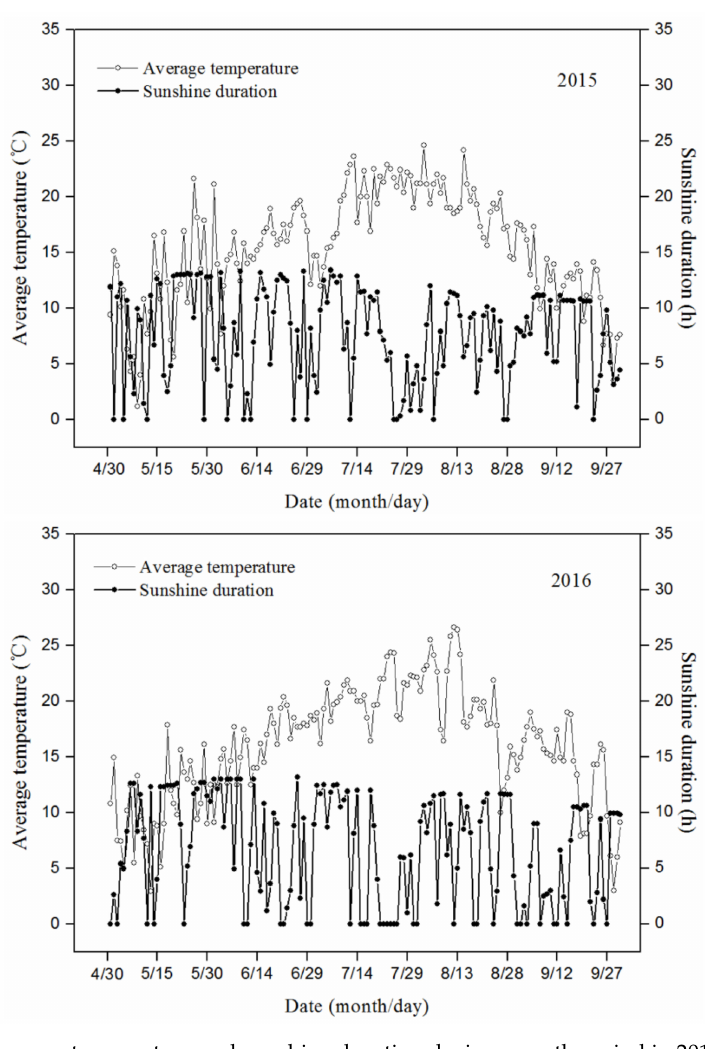
Figure 1. Average temperature and sunshine duration during growth period in 2015 and 2016.